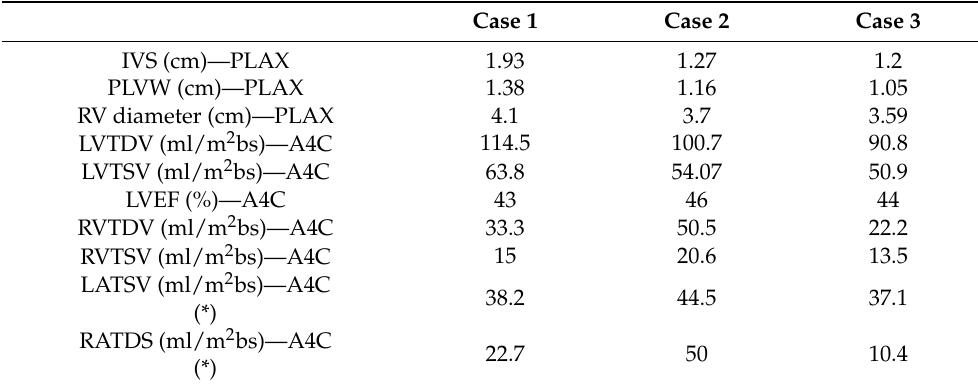
Table 2. Transthoracic echocardiographic findings of the three patients made in sinus